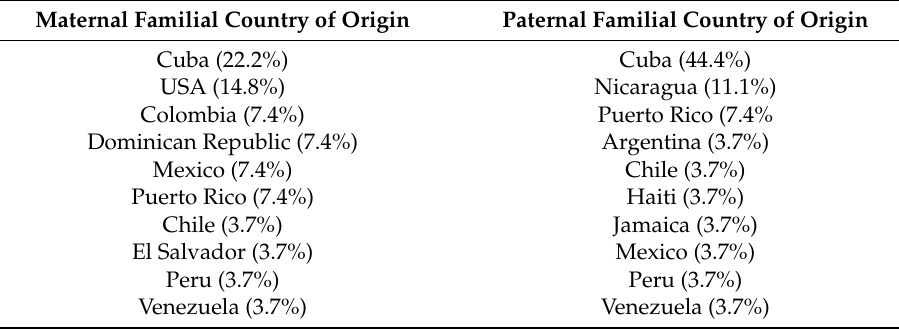
Table 2. Maternal and paternal familial country of origin in mixed Hispanic